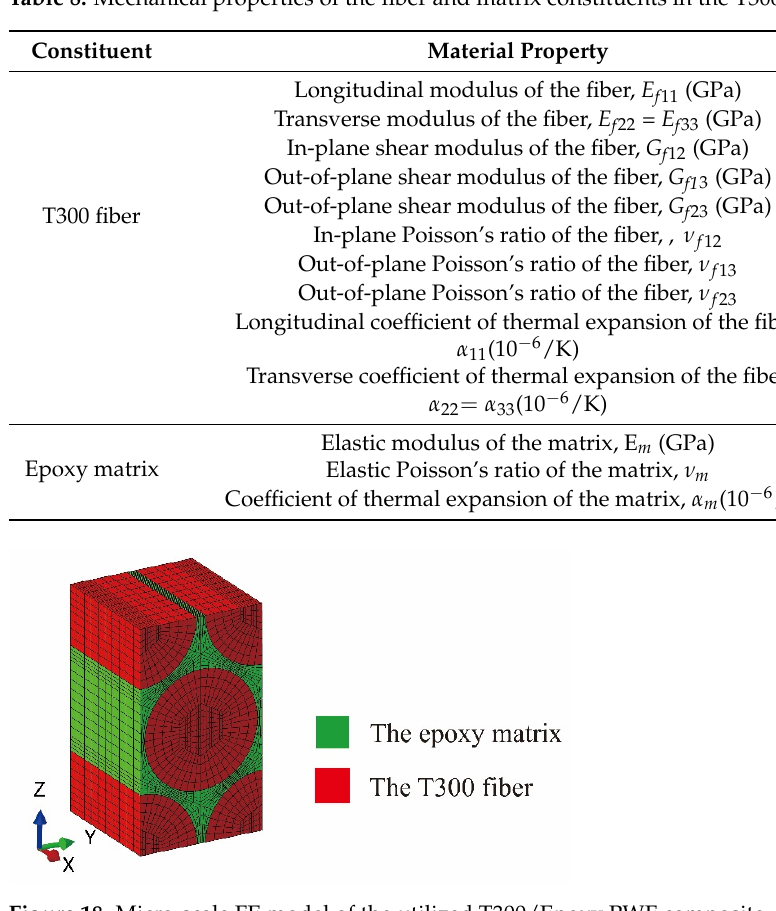
Figure 18. Micro-scale FE model of the utilized T300/Epoxy PWF composite. Table 8. Mechanical properties of the fiber and matrix constituents in the T300/Epoxy composite.